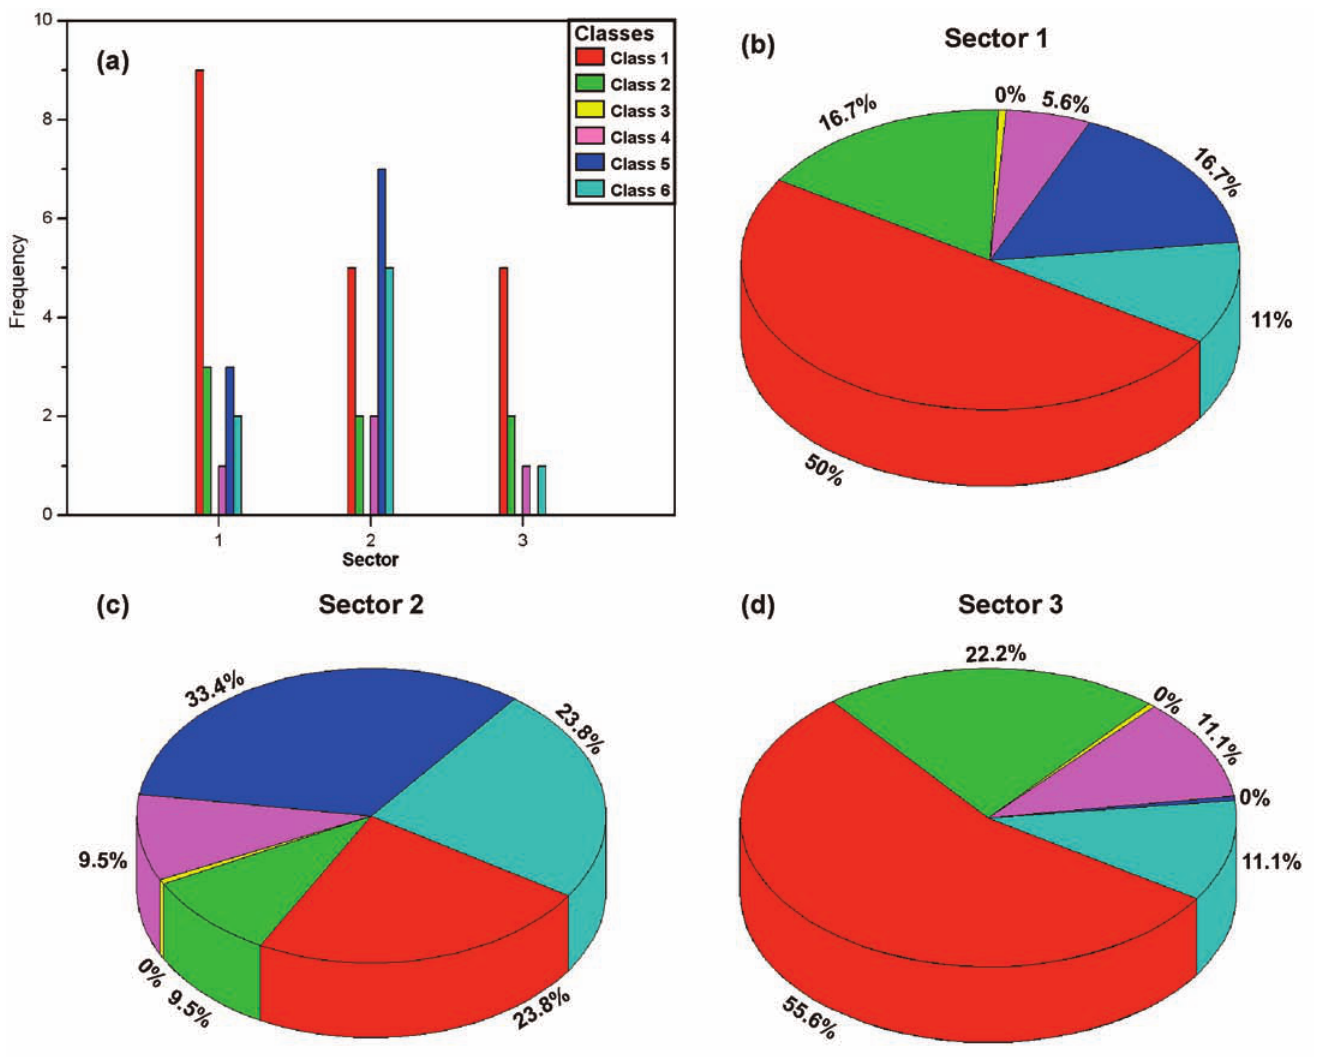
Figure 7. a) Distributions of the six classes in the three sectors into which Etna was divided. The legend refers to all of the panels. (b-d) Pie diagrams showing the distributions of the six classes, as: sector 1 (b), sector 2 (c) and sector 3